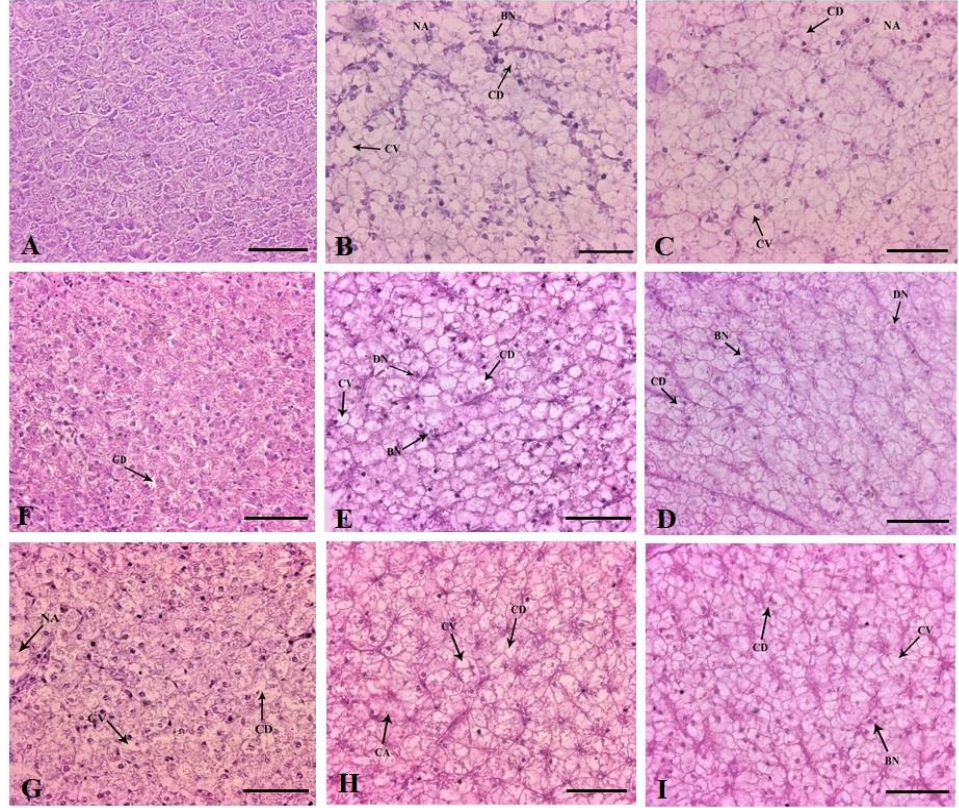
Figure 7. Histoarchitectural structures of the liver tissues of ( A ) control with normal hepatocytes and parenchyma ×200 and dietary florfenicol (FFC)-administered Oreochromis niloticus juveniles for 10 consecutive days on day 10 FFC-dosing at ( B ) 15 mg kg biomass −1 day −1 [1×], ( C ) 45 mg kg biomass −1 day −1 [3×], ( D ) 75 mg kg biomass −1 day −1 [5×] and ( E ) 150 mg kg biomass −1 day −1 [10×], ×200, and on day 43 post FFC dosing at ( F ) 1×, ( G ) 3×, ( H ) 5× and ( I ) 10×, ×200 showing glycogen-type vacuolation, cytoplasmic vacuolation (CV), cytoplasmic degeneration (CD), necrotised areas (NA) and binucleated cells (BN); H&E staining. Scale Bars ( A – I ): 25 μm. Table 2. The histoarchitectural changes in Oreochromis niloticus juveniles upon dietary FFC admin- istration at 1 – 10 times the therapeutic dose of 15 mg kg biomass −1 day −1 for 10 consecutive days as assessed qualitatively on a 6-point ordinal scale * in comparison to the normal architecture.